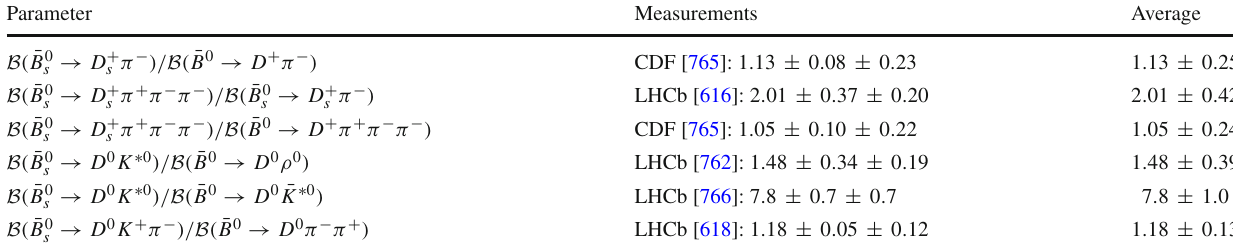
Table 190 Relative decay rates I